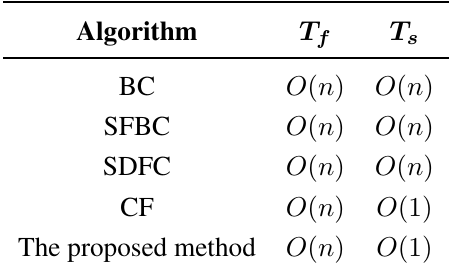
Table 1. Time complexity comparisons. SFBC, spectral feature-based binary coding; SDFC, spectral derivative feature coding; CF, crosscut feature.